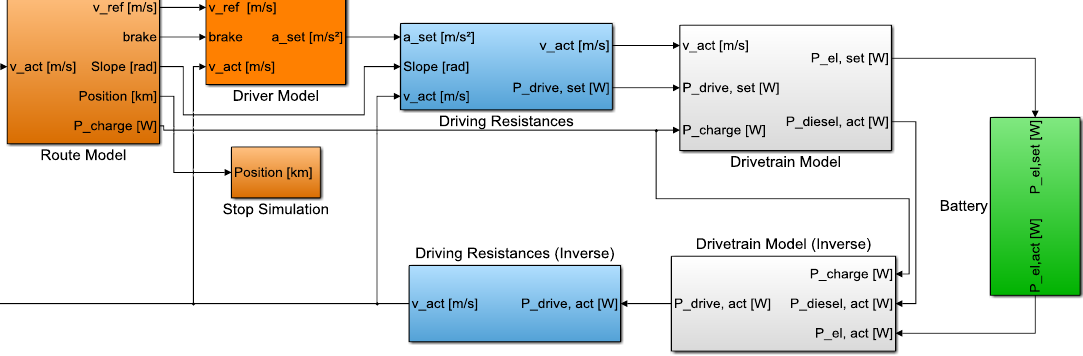
Figure 3. Overview of the truck simulation model containing electric and diesel drivetrain types inside the drivetrain model block.